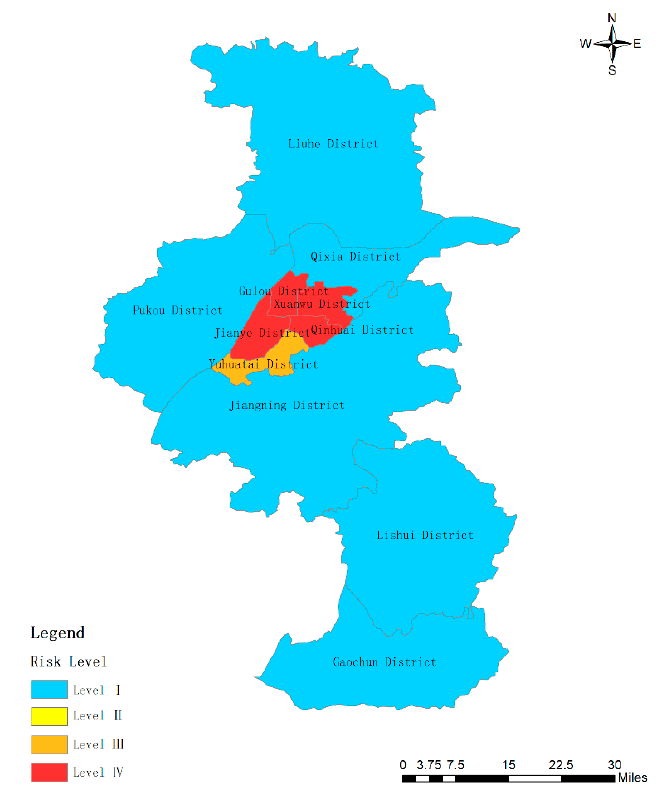
Int. J. Environ. Res. Public Health 2020 , 17 , x Figure 3. Risk level of subsystem 𝑌 (cid:2870)(cid:2869) in Nanjing. Figure 3. Risk level of subsystem Y 21 in Nanjing.